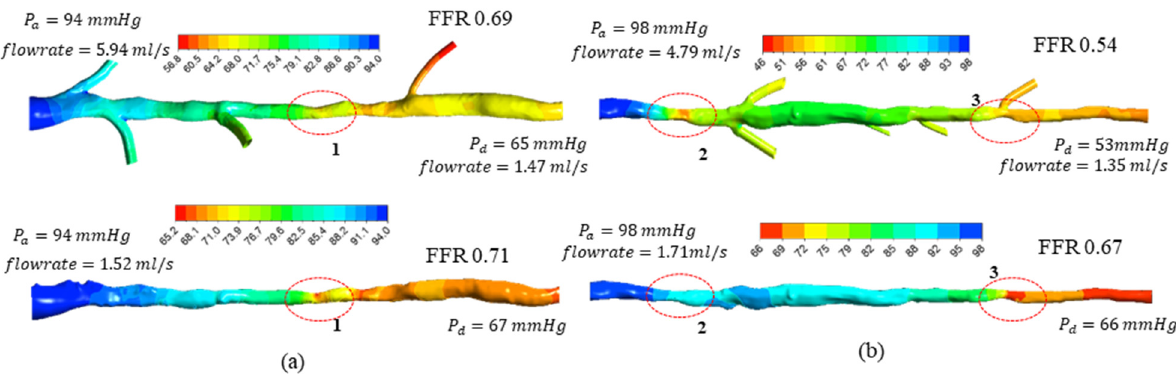
Figure 6. CFD-derived pressure distribution of OCT-derived vessel tree models with (top) and without (bottom) side branches for ( a ) patient 1 and ( b ) patient 2. Severely stenosed regions are enclosed with dashed lines.